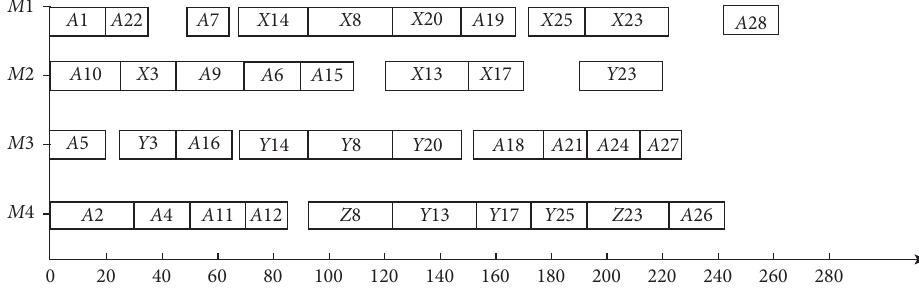
Figure 8: Reverse scheduling results of the time-selective strategy of Multiple-Devices-Process.